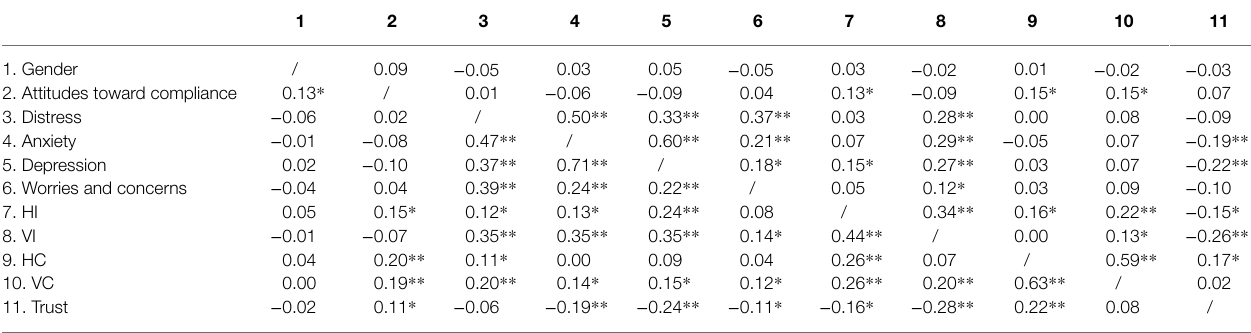
TABLE 2 | Correlations between the key variables ( n =